Question: Condense the content of this figure into a single sentence.
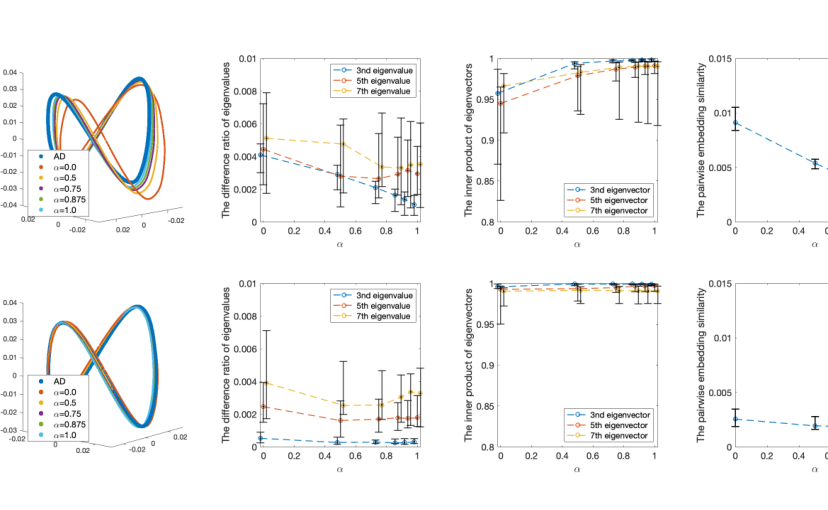
Answer: Top row, from left to right: α-LAD with various α, the difference ratio of the 2nd, 4th, 6th non-trivial eigenvalues between AD and α-LAD, the inner product between the 2nd, 4th, 6th non-trivial eigenvectors of AD and α-LAD, where we plot the top 6 eigenvectors, and the embedding similarity between AD and α-LAD, where the landmark distribution is non-uniform. Bottom row shows the same thing but when the landmark distribution is uniform.